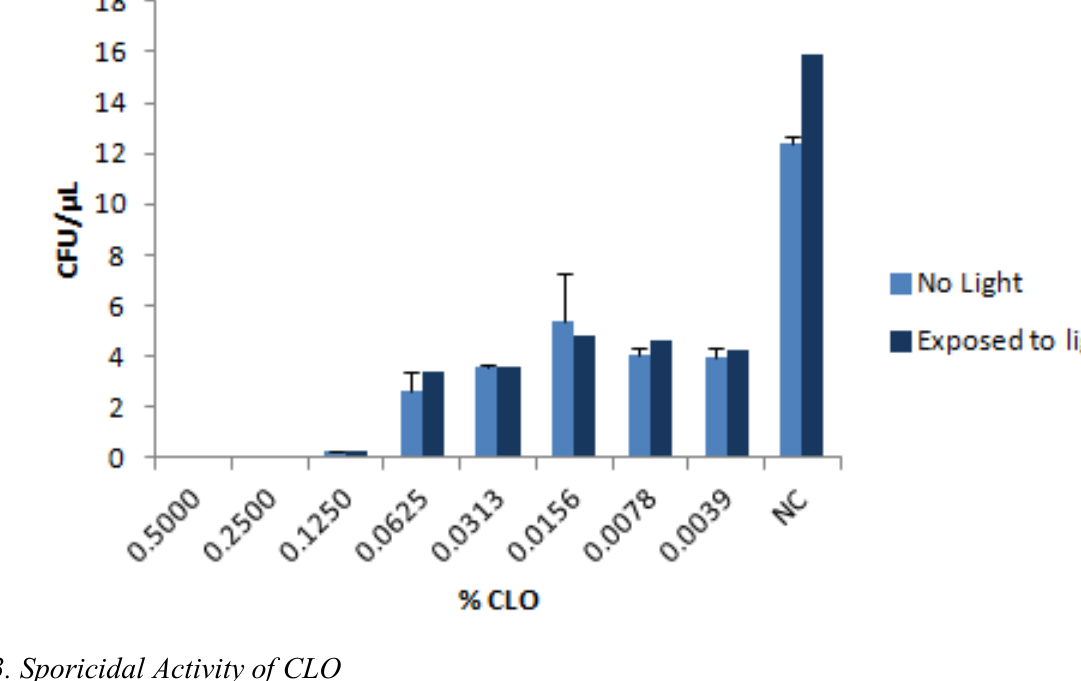
Figure 3. Effect of light exposure on antibacterial property of CLO. Reactions contained 1,500 cfu of B. subtilis and the indicated concentration of CLO. Half the reactions were exposed to fluorescent light in the biosafety cabinet, and the others were completely covered in aluminum foil to exclude light. Reactions were processed and assayed for cfu as usual, in comparison to the untreated control